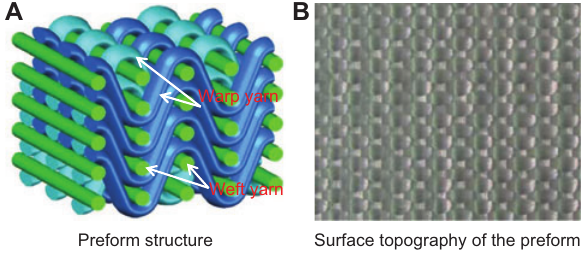
Figure 2 Geometry and dimensions of shear specimen (dimensions in mm).